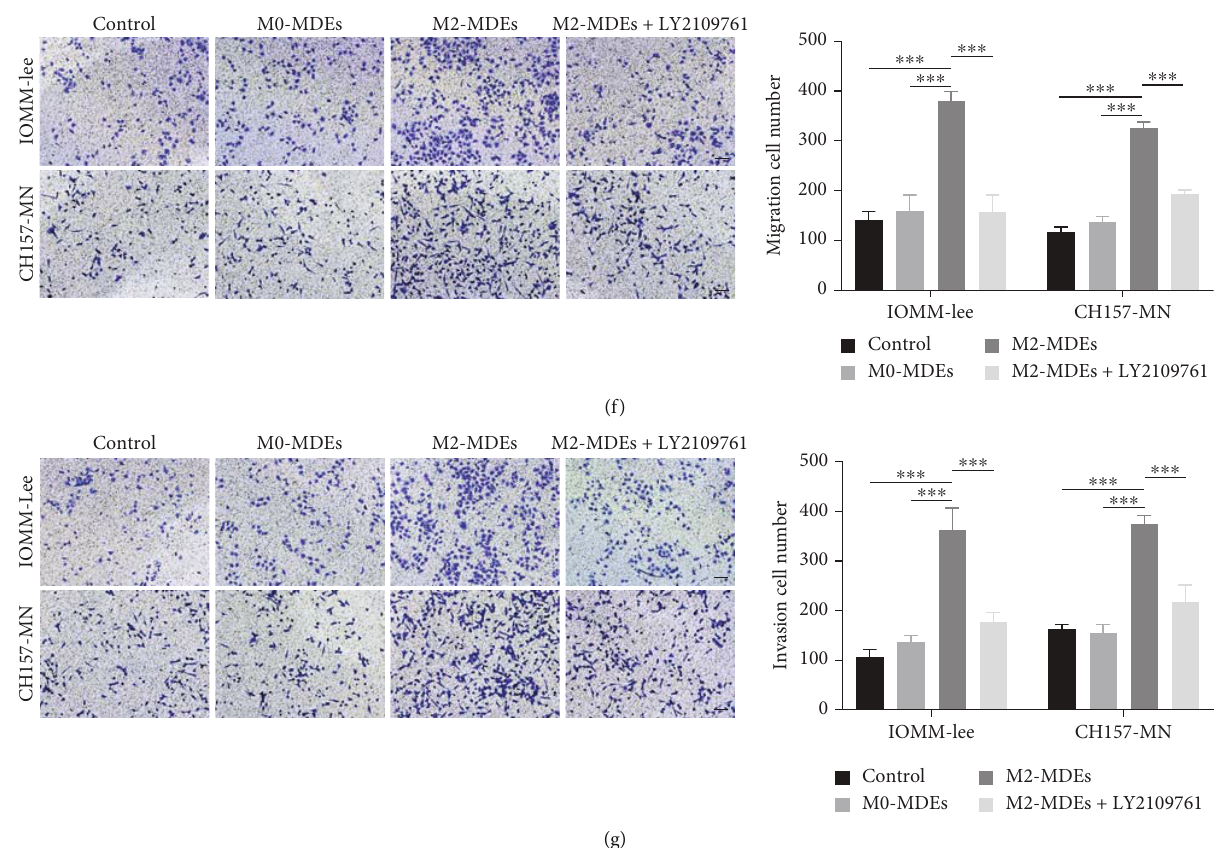
Figure 5: Inhibition of the TGF- β pathway reverses the tumor-promoting biological e ff ects mediated by M2-MDEs. (a) Western blot detection of protein expressions of TGF- β 1, p-Smad3, Smad3, p-Smad2, and Smad2. (b) The expressions of Smad2 and Smad3 in nuclear and cytoplasmic protein fractions, respectively, were detected by western blotting. β -Tubulin and lamin B1 serve as house- keeping genes for cytoplasmic and nuclear proteins, respectively. (c) Detection of cell viability of IOMM-Lee and CH157-MN cells by CCK-8 assay. (d) EdU staining was used to label tumor cells in the proliferating state, and the EdU+ cell ratio was detected by fl ow cytometry. (e) Western blotting for the expressions of EMT-related genes. (f) Transwell chambers were used to detect tumor cell migration ability. (g) Transwell chambers preincubated with Matrigel were used to assess tumor cell invasiveness. ∗ p < 0 : 05 , ∗∗ p < 0 : 01 , ∗∗∗ p < 0 : 001